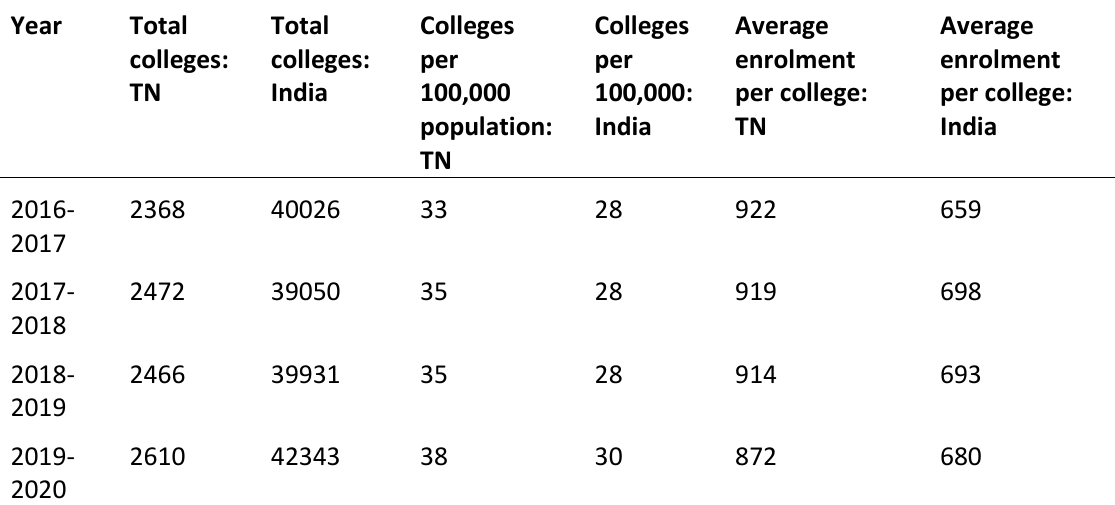
Colleges per Population and Student Enrolment (2016-2020). Data correlated from All India Survey on Higher Education 2019-2020 (Ministry of Education,